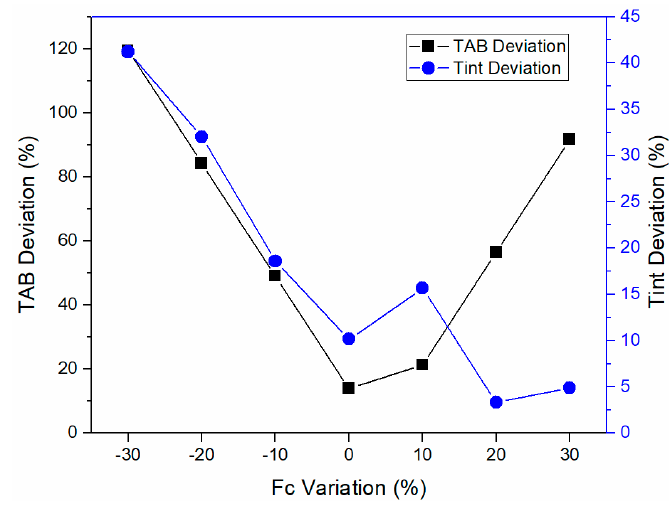
Figure 3. Sensitivity study of input cutting force. Variation of cutting force is ±30%.